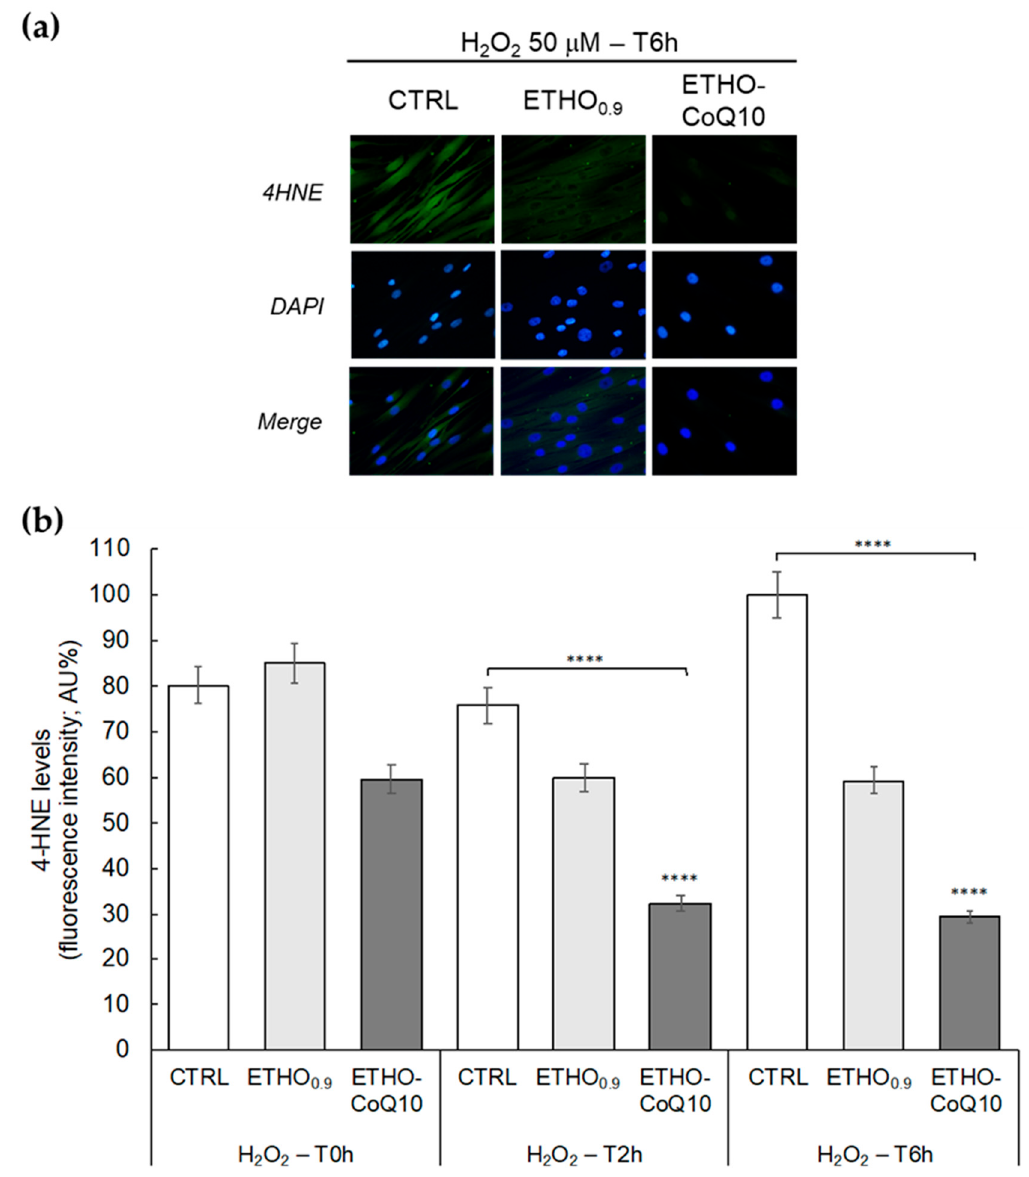
Figure 6. ( a ) Representative immunocytochemical images of 4HNE protein adducts in primary dermal fibroblasts without treatment (CTRL), treated with ETHO 0.9 or ETHO-CoQ10, 6 h after exposure with 50 µ M of H 2 O 2 for 1 h. Images were taken at 40 × . ( b ) Quantification of immunofluorescence staining for 4HNE immediately after H 2 O 2 exposure (T0 h) or 2 (T2 h) and 6 h (T6 h) post-exposure. Data were normalized with respect to the CTRL sample treated for 6 h and expressed as arbitrary units ± SD. **** p ≤ 0.0001 vs. CTRL T0